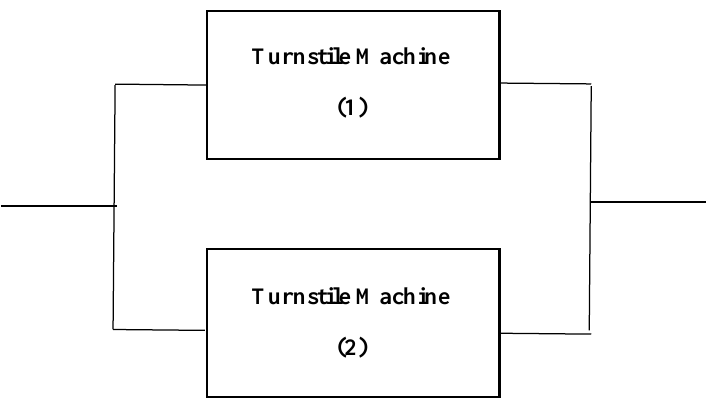
Figure 1. Reliability block diagram of turnstile